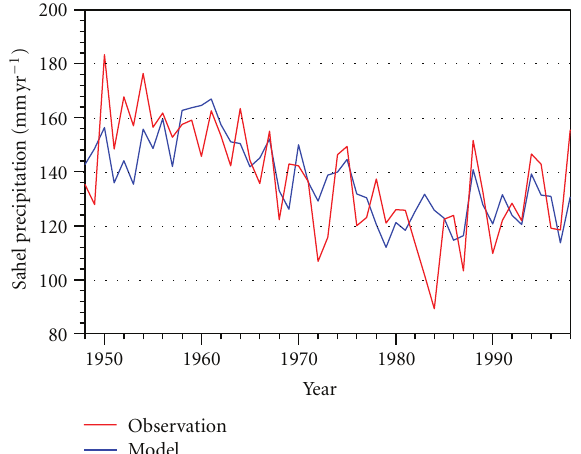
Figure 2: Sahel precipitation in mmyr − 1 : data and regression on the basis of SAL pressure and AZH longitude.